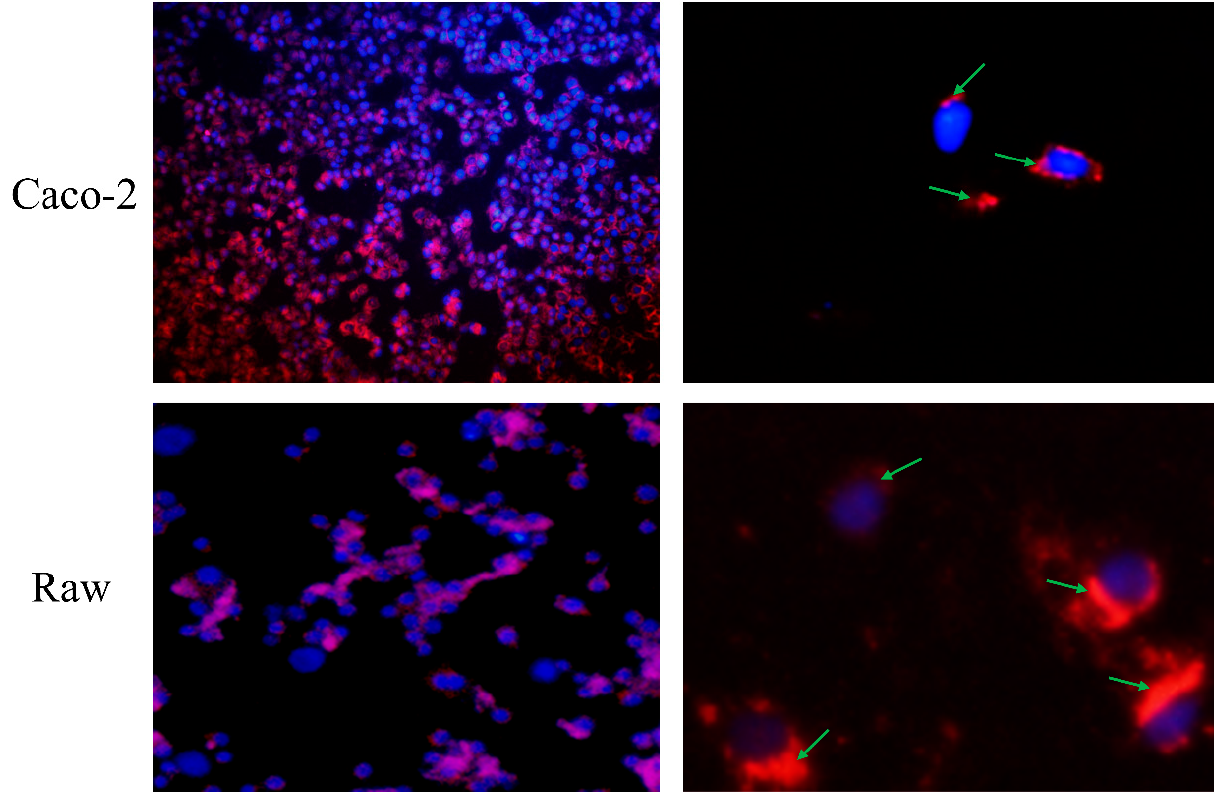
Figure 4. Observation of direct effects of Caco-2 cells and Raw 264.7 on the CNPs. The two images on the left are panoramic views, while the two images on the right are partial views. The nuclei were stained blue, while the CNPs were stained red. After incubation, the CNPs wrapped around the nucleus, as indicated by the green arrow.